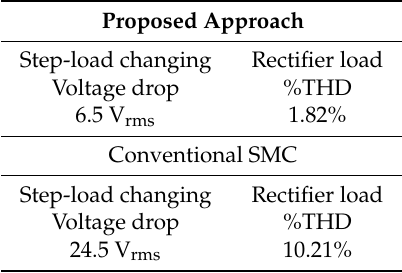
Figure 11. Experimental construction. Table 3. Experimental comparison of output voltage drop and %THD.